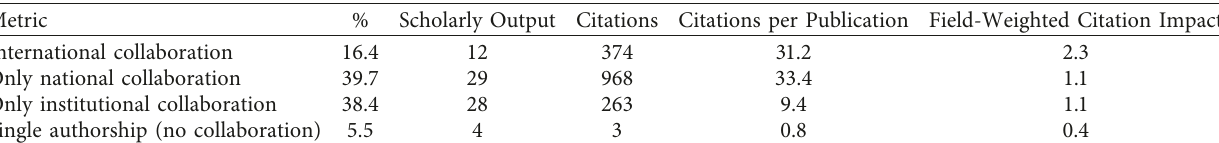
Table 5: All publication types in caries vaccine by the amount of international, national, and institutional collaboration. Metric %